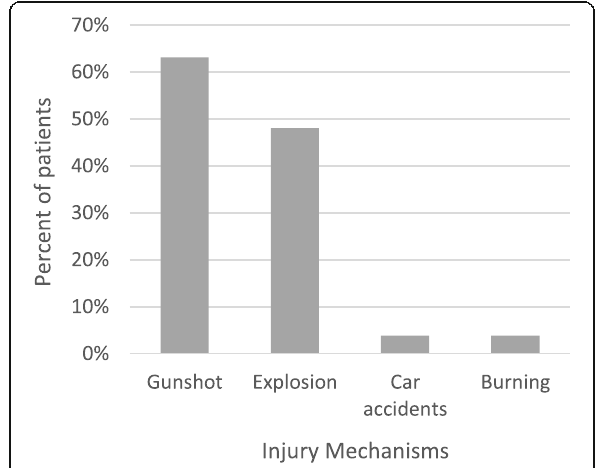
Fig. 2 Injury Mechanisms. Frequency of gunshots, explosions, car accidents and burning